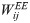
Self-organization imprints stimulus properties in the network.(a) The conditional probability of x
i spiking given that x
j just spiked (p(x
i(t + 1) = 1|x
j(t) = 1)) is roughly proportional to their synaptic connection WijEE except for saturation effects for very large weights. (b) The firing probabilities of each neuron relative to stimulus onset. The network develops sequential activity patterns during the presentation of both sequences (top and middle) and during spontaneous activity (aligned to spontaneous states corresponding to “C”, bottom). Neurons were sorted according to their maximal firing probability relative to the sequence “ABCD”. (c) The prediction of transition probabilities during spontaneous activity from the singular value decomposition of W
EE. (d) The actual transition probabilities during spontaneous activity show intermediate switching between the two sequences probably due to variability introduced by intrinsic plasticity (see Discussion for details).